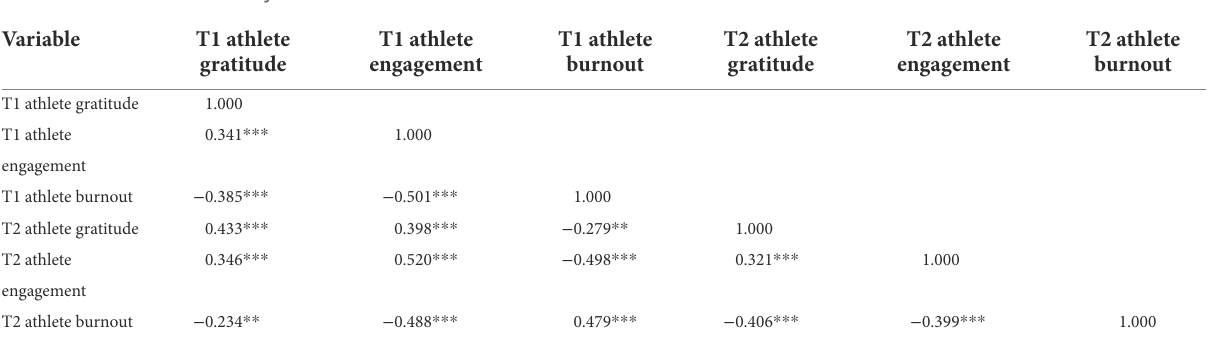
Athlete engagement